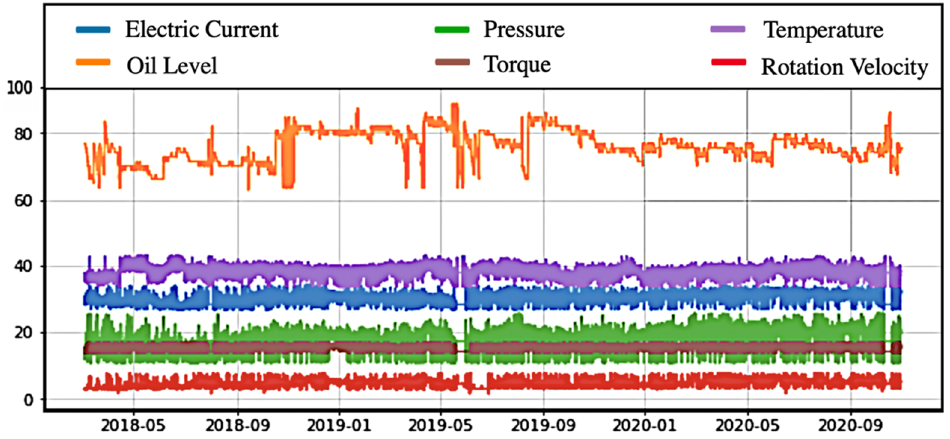
Figure 1. Plot of sensor data collected from 2018 to 2020 with a sampling period of 1 min. Raw data as provided by the company.